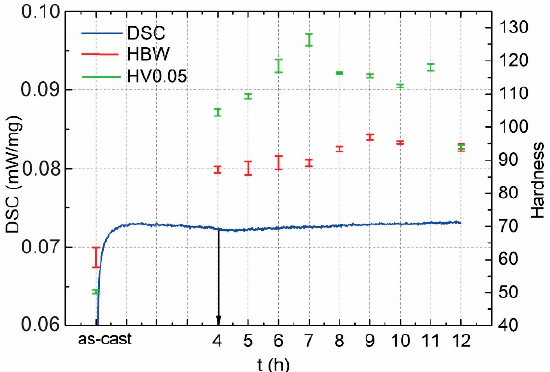
Figure 3. DSC measurement of homogenisation annealing of EN AW 2011 aluminium alloy at 520 °C 12 h and hardness results of alloy (HBW) and matrix (HV).